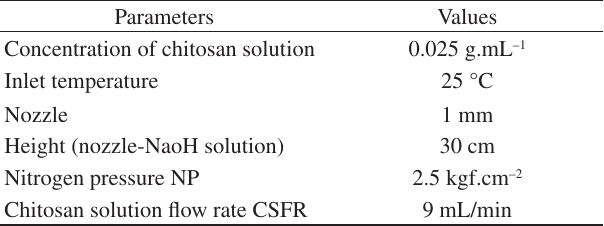
Table 6. The optimized conditions for chitosan microparticle production.